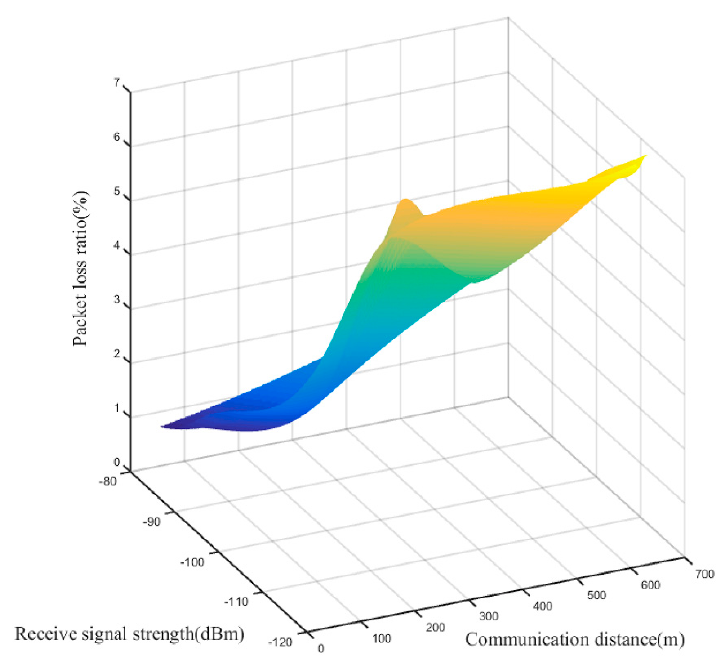
Figure 12. Influence of different communication distance on link quality.